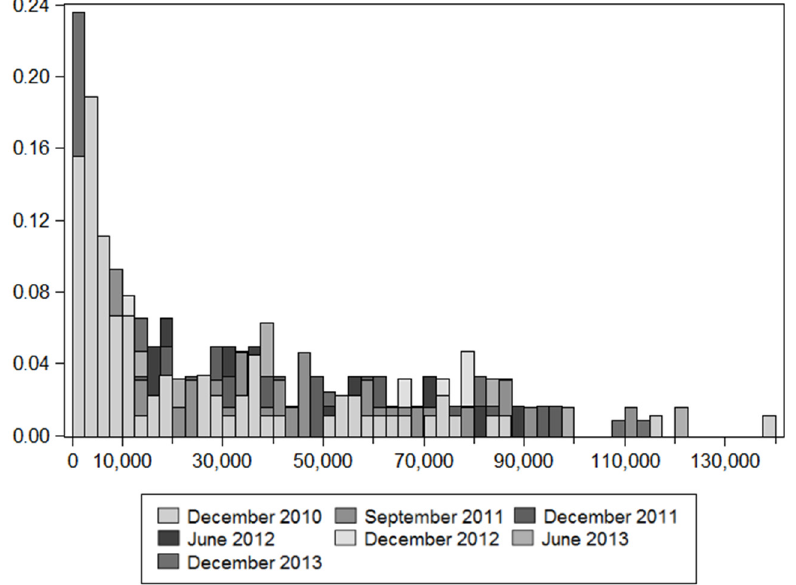
Figure 3. Histogram of the Weighted Out-Degrees. Nodes with smaller weighted out-degrees, i.e. , with smaller portfolios of government debt, make up the larger part of the network in terms of absolute numbers. Distributions are overlapped for the seven recording